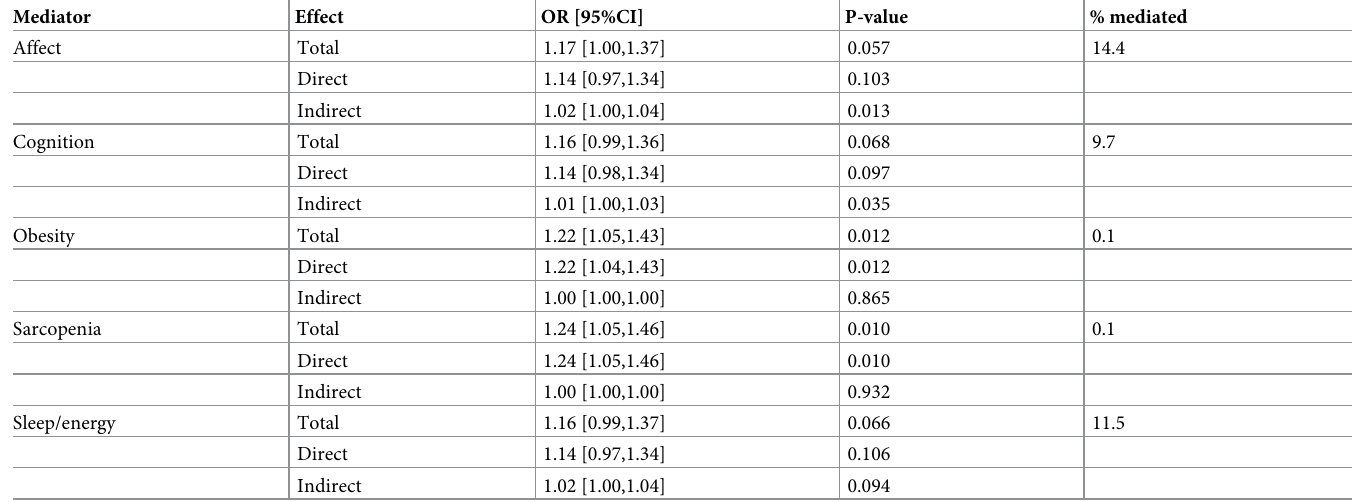
Table 3. Mediating effects of affect, cognition, obesity, sarcopenia, and sleep/energy in the association between active travel and physical multi-morbidity. Mediator